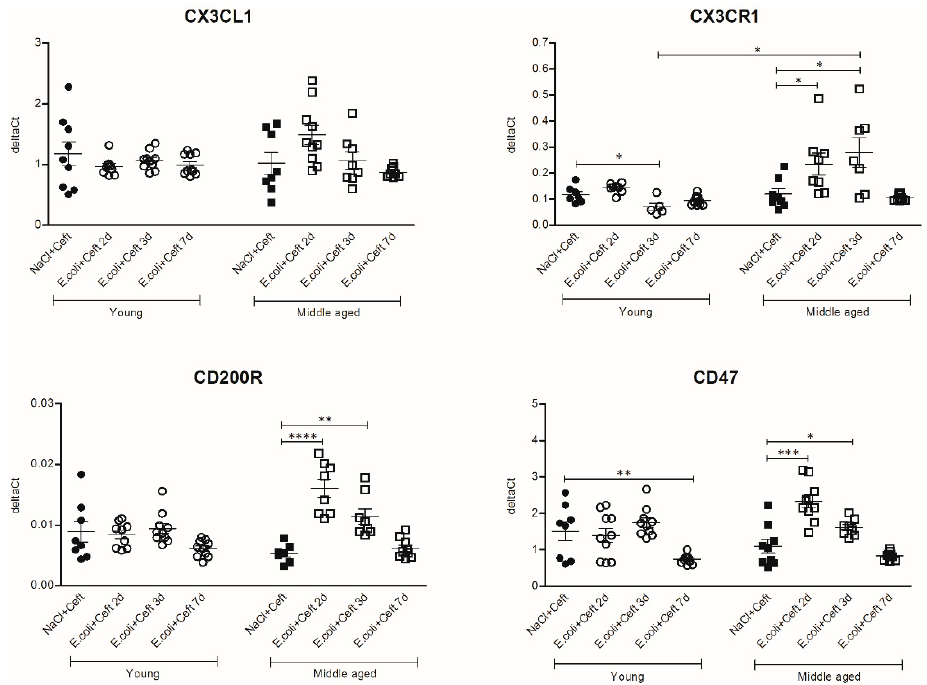
Figure 8. mRNA expression of brain homogenate of specific microglial genes with anti-inflammatory effects: CX3CL1- CX3CR1, CD200R and CD47, illustrated in deltaCts. Group size varies from n = 8 to 10. Parametric or non-parametric two-way ANOVA (factors: age and time point) were conducted and continuous variables were tested with post-hoc Mann–Whitney U tests or Student t -tests, depending on the distribution of the data. For non-parametric ANOVAs, ranked transformation of the data was performed. Data represent mean ± SEM, * p ≤ 0.05, ** p ≤ 0.01, *** p ≤ 0.001, **** p ≤